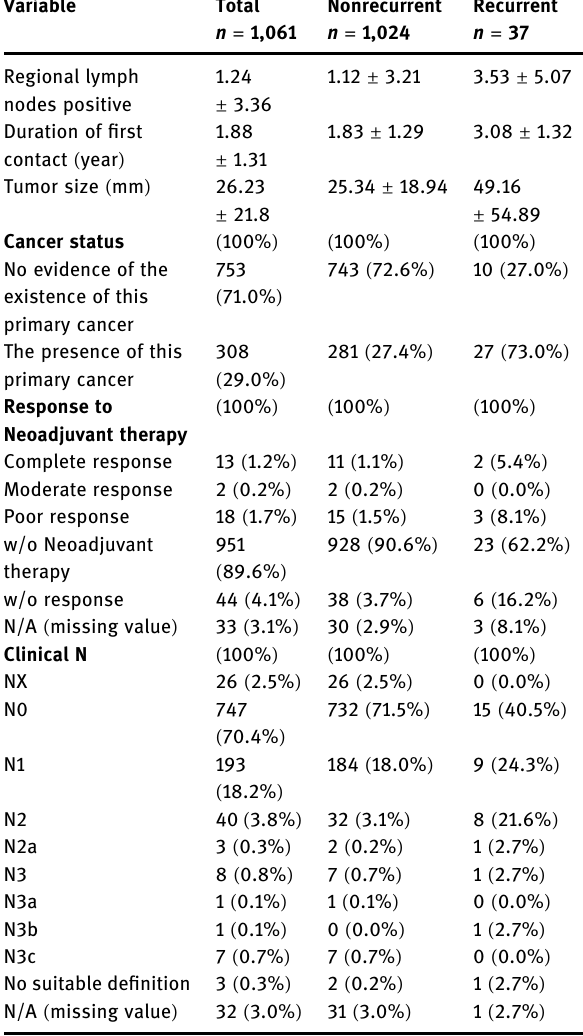
Table 3: The statistics of selected features by the feature selection algorithm